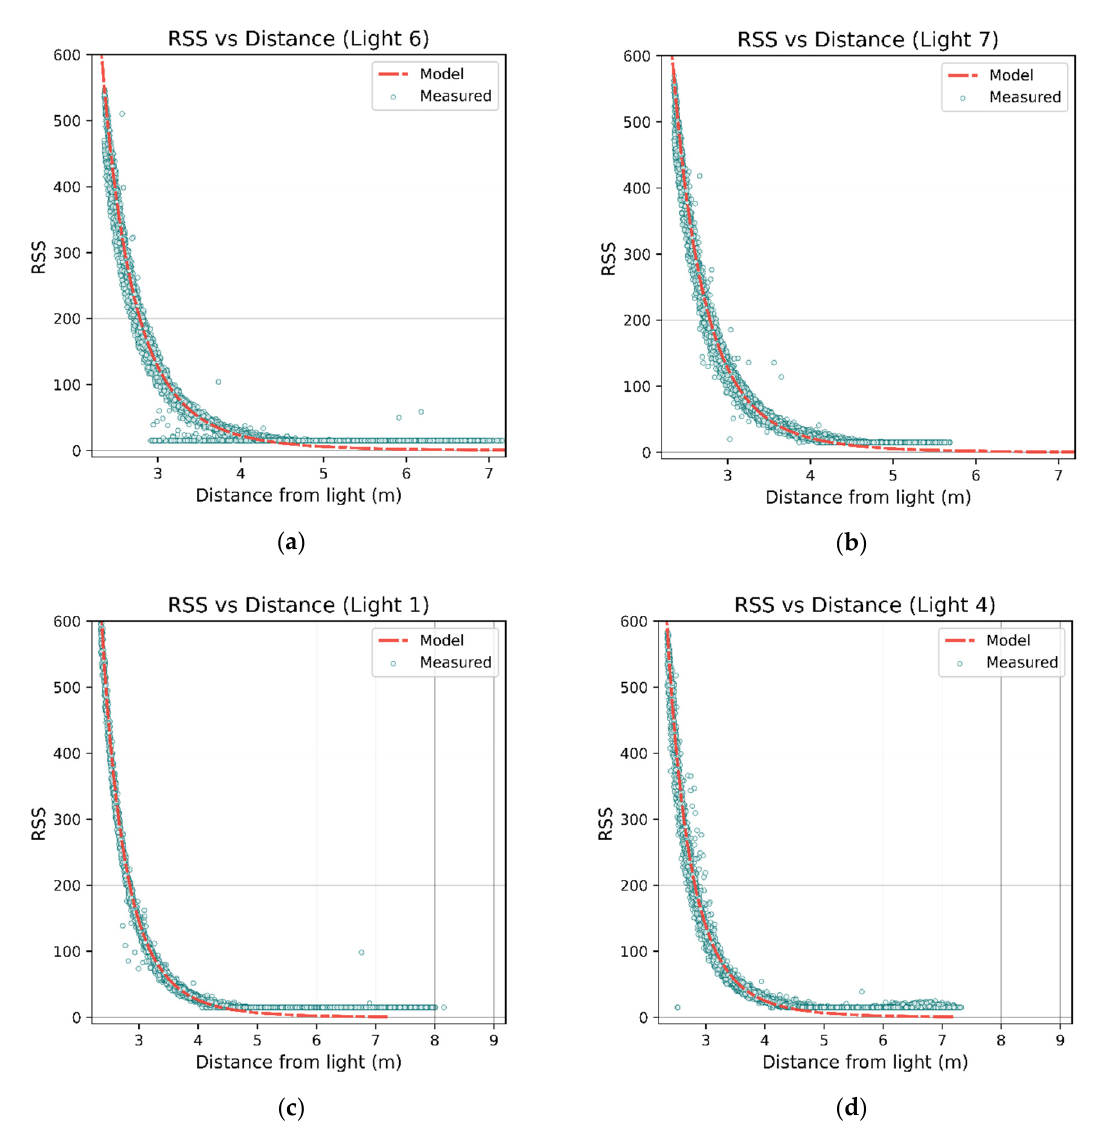
Figure 17. RSS vs. distance plots for luminaires 6, 7, 1, and 4 in ( a – d ) respectively. The red lines show the trained Lambertian models. Luminaire 6 in (a) shows clear deviation due to the presence of the pillar; some effects can be seen in luminaires 1 and 7 (in ( b , c )), although not as severe. Luminaire 7 is located close to the center of the room and therefore does not have as wide a range of distances compared to the others. Clamping of the RSS values can also be clearly seen in all plots, as the distance increases and readings do not follow the Lambertian model (which approaches